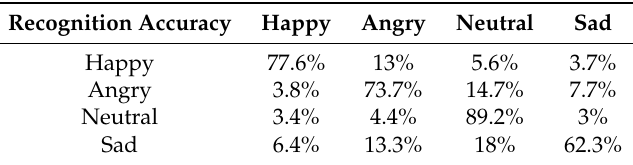
Table 8. Confusion matrix of emotional